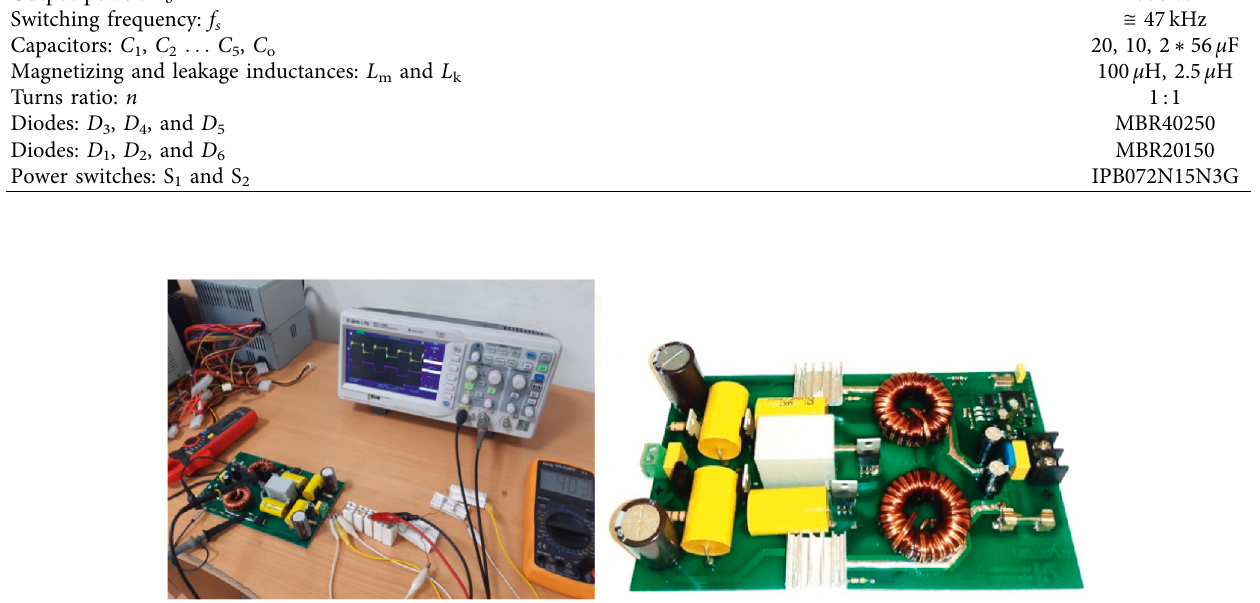
Figure 12: Image of the prototype and laboratory tests.